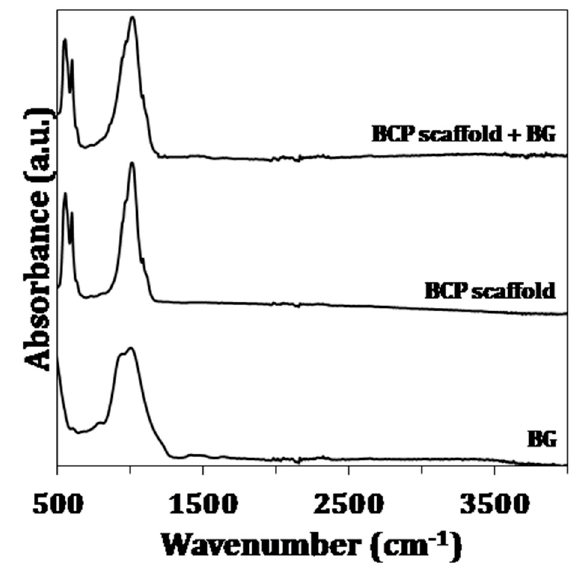
Figure 2. FTIR spectra of sol-gel derived BG, BCP scaffolds and BG-coated scaffolds.